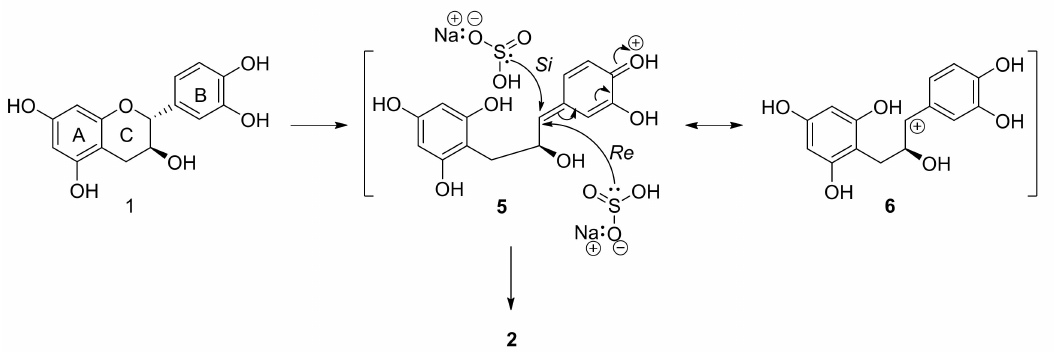
Scheme 2. Proposed mechanism of the sulfitation of catechin 1 .